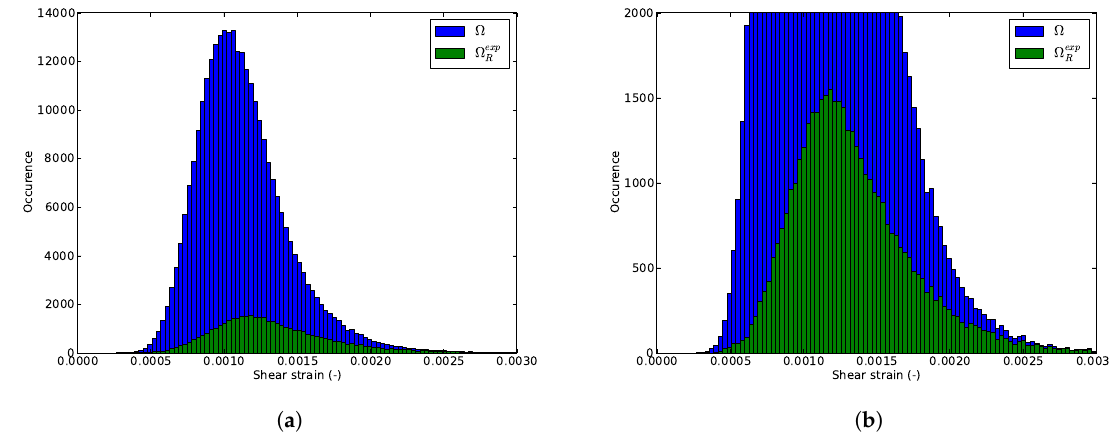
Figure 14. Shear strain distributions ( a ) in the whole domain and ( b ) in the RED at the first step.